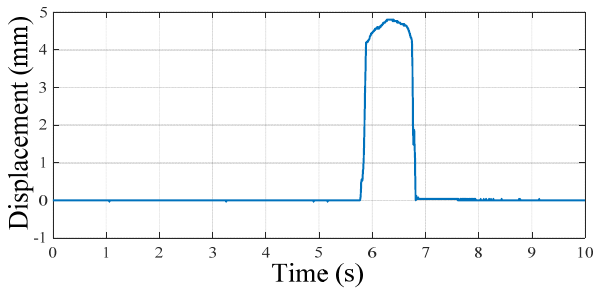
Figure 8. Displacement curve of the upper plate of the floor structure.